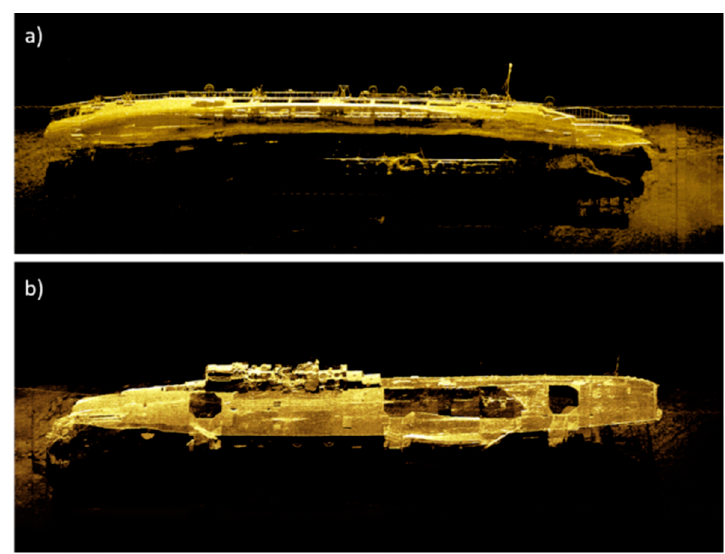
Figure 18. Sonograms acquired with a towed side-scan sonar DF-1000: ( a ) using operational parameters R = 100 m; Fa = 47 m; D = 24 m; ( b ) using operational parameters R = 100 m; Fa = 42 m; D = 28 m.